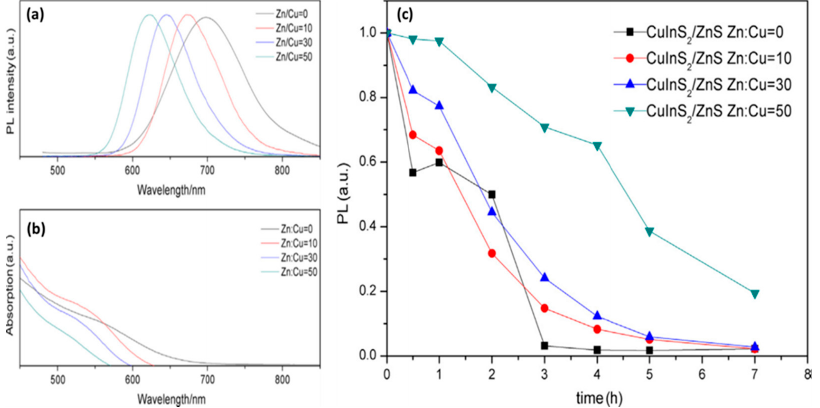
Figure 10. PL: ( a ) UV-vis spectra ( b ) and photostability spectra ( c ) of CIS and CIS / ZnS with di ff erent Zn ratios